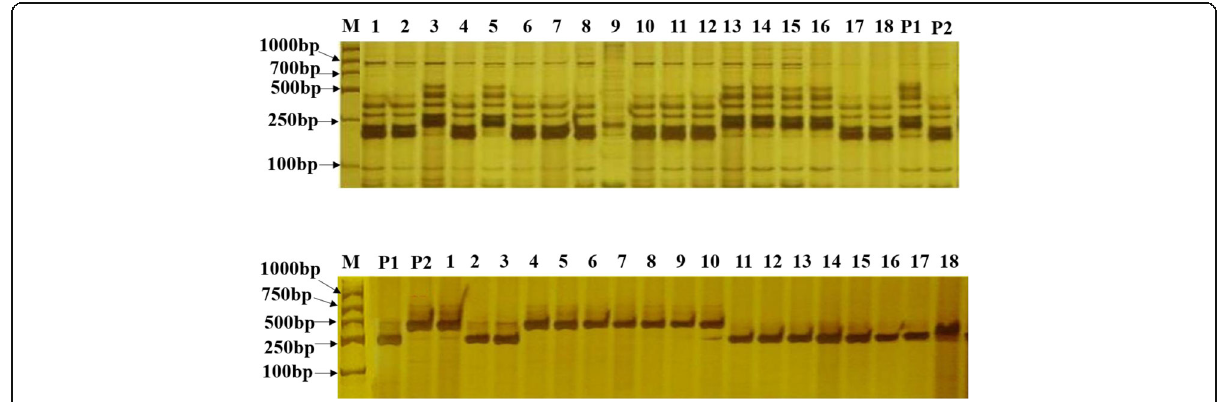
Fig. 3 Detection of SSIIa and SSIIIa gene in 64 semi waxy lines